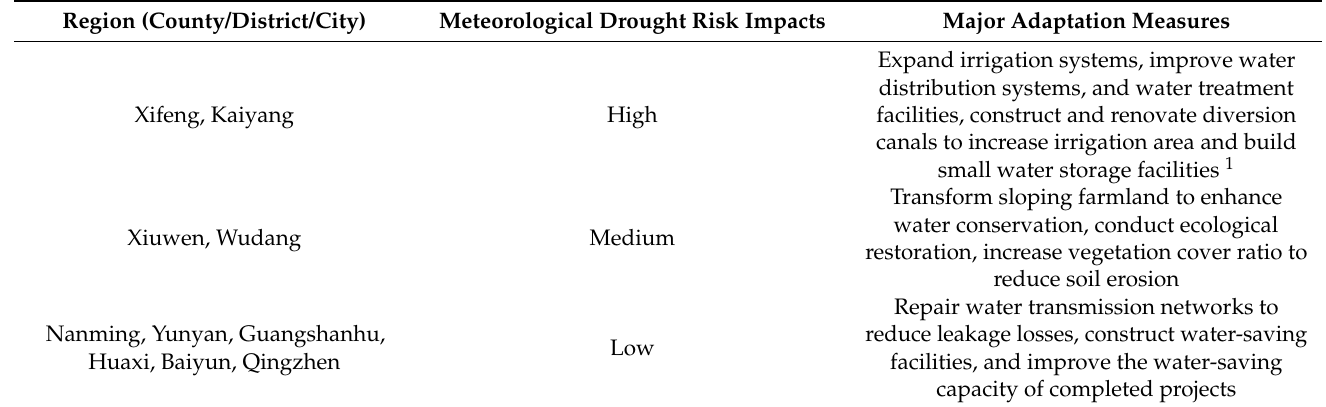
Table 1. Agrometeorological drought adaptation actions proposed in Guiyang MTSP.